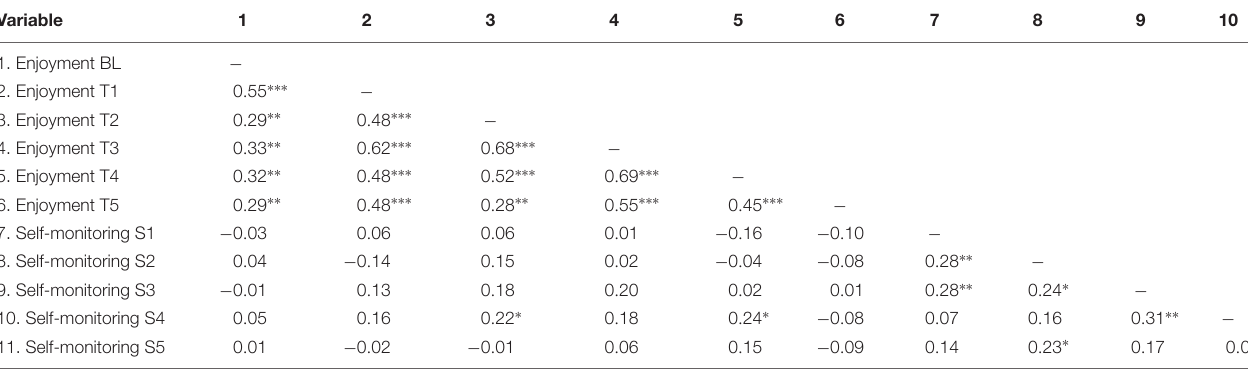
TABLE 3 | Pearson correlations between single measurement occasions of enjoyment and self-monitoring.